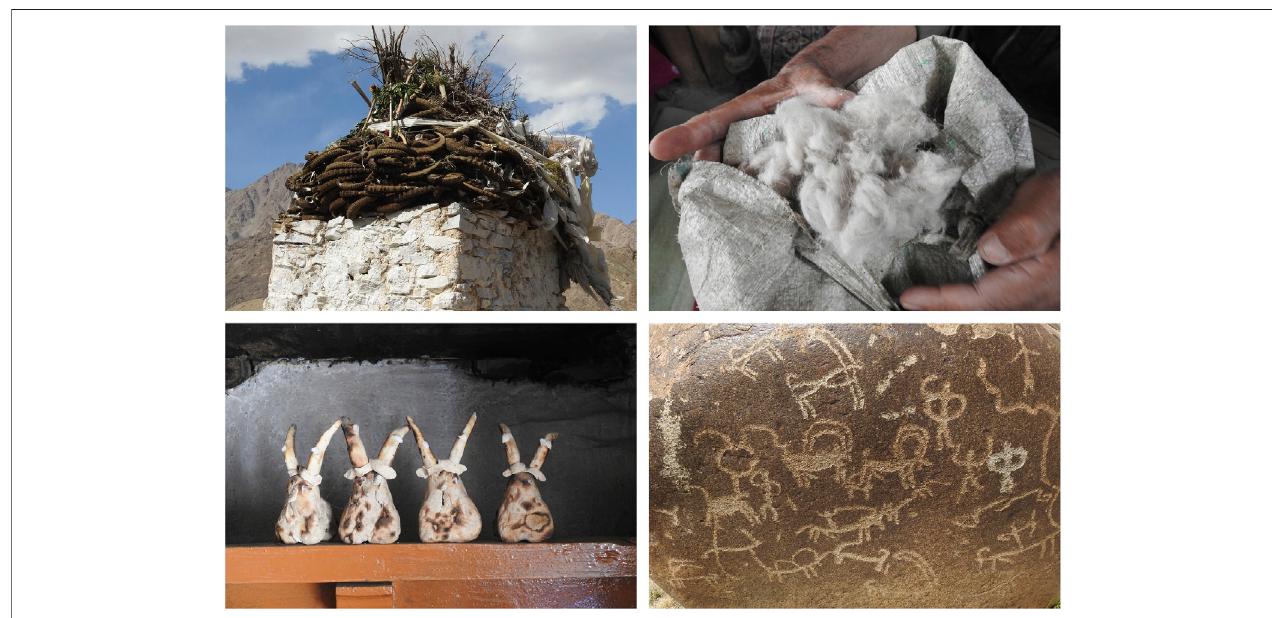
FIGURE 2 | Clockwise from top left: Image of a lhato — a structure dedicated to local protective deities consisting of ibex, asali tus or ibex undercoat, petroglyphs depicting the ibex and people, ibex fi gurines made of dough prepared as an offering to the deity during Losar (New Year) and at the time of birth of a male child.